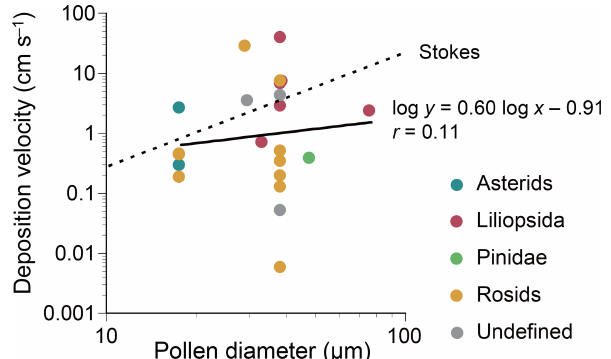
Figure 6. Dry deposition velocities of the plant genera listed in Ta- ble 1. Each point represents a datum for each genus. Interfilum and Trebouxia , which are algal genera, were excluded. For each genus, a mean value of lower and upper values of reported pollen diameters is used for a representative pollen diameter. In case pollen grains are non-spherical, a mean value of the reported length and width is used. The Stokes terminal gravitational settling velocities are calcu- lated by assuming that pollen grains are spherical and have a stan- dard density of 1.0gcm − 3 . The velocities are calculated by: V Stk = ρ 0 d 2 g/ 18 η where ρ 0 is the standard density ( = 1 . 0gcm − 3 ), d is the pollen diameter, g is the acceleration of gravity ( = 980cms − 2 ), and η is the viscosity of air ( = 1 . 8 × 10 − 5